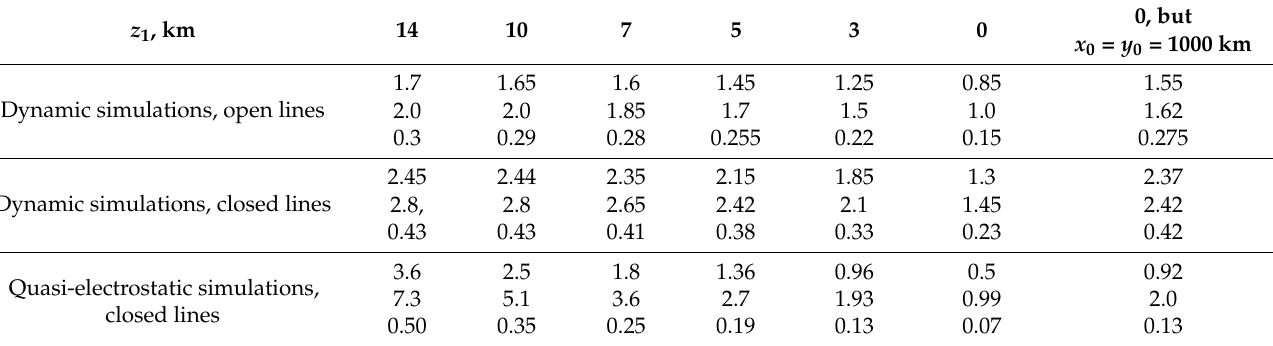
Table 1. The dependencies of the maximum values of |E x |, |E y |, |E z |, mV/m, on the position of the excitation current z 1 , the circular frequency is ω = 0.025 s − 1 . The inclination angle of the geomagnetic field is θ i = 10 ◦ . There are the same